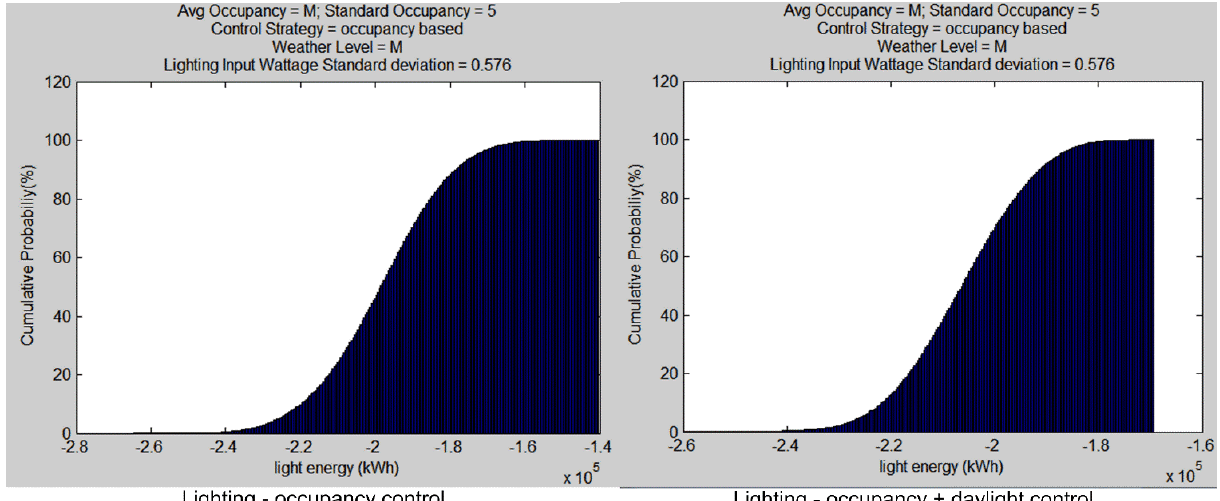
Figure 11. CDFs of HVAC energy difference between retrofit and existing lighting